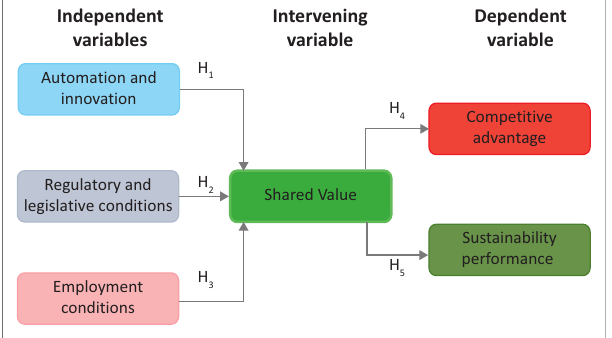
FIGURE 2: Revised hypothesised model of the impact of Shared Value within the South African mining industry. TABLE 3: Descriptive statistics of the independent, intervening and dependent variables.